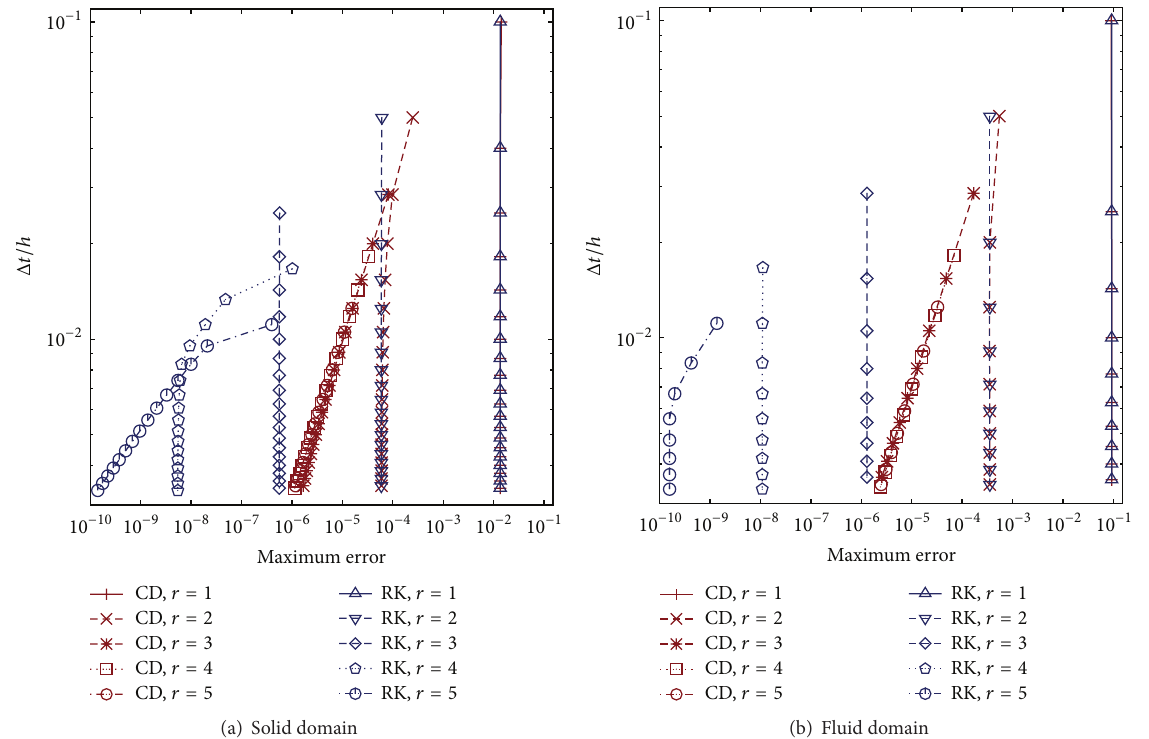
Figure 4: Comparison between maximum errors with the CD and the RK time discretizations. The mesh step size is fixed to be ℎ = 1/20 , and the time step refinement gives a series of numerical results with various lengths of the time step for each element order.